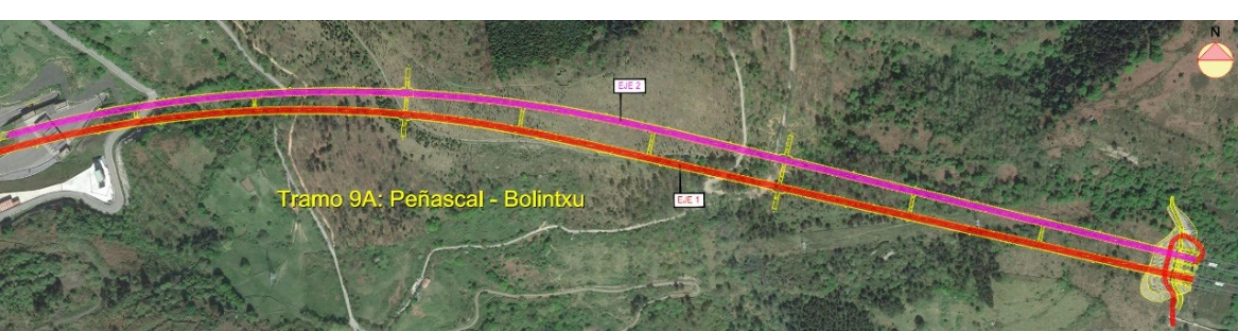
Figure 2. Arnotegi road tunnel floor plan